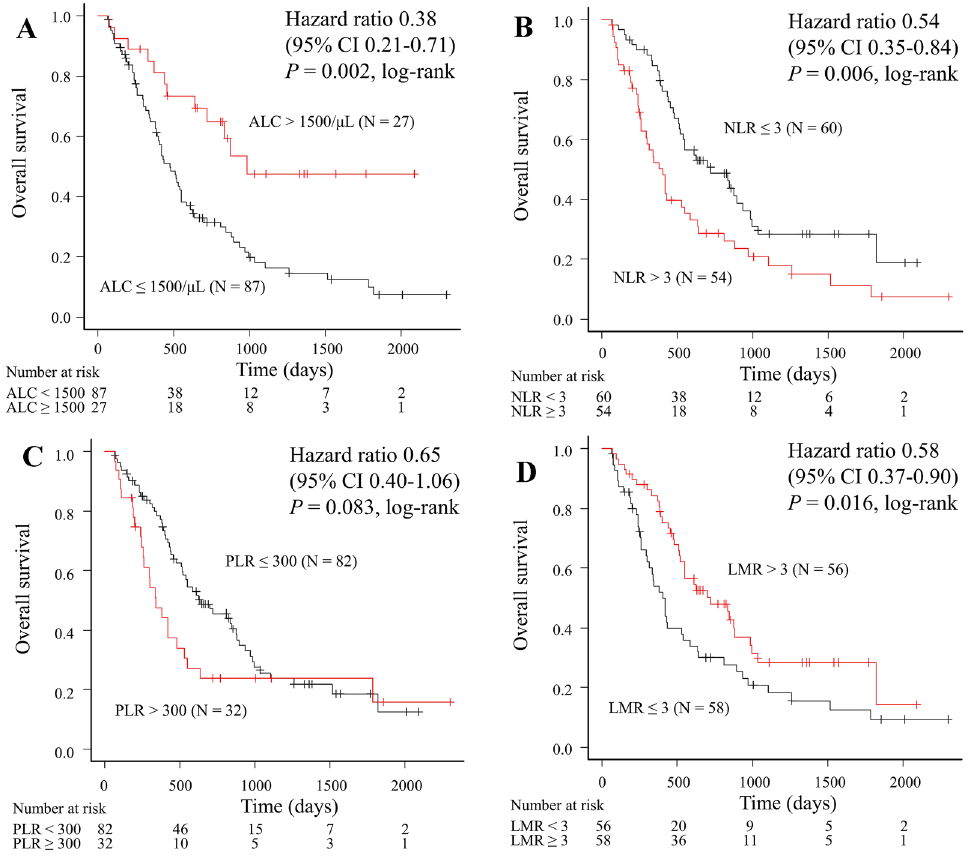
Figure 2. Overall survival according to baseline levels ( A ) ALC, ( B ) NLR, ( C ) PLR, and ( D ) LMR in patients treated with paclitaxel plus bevacizumab. ALC absolute lymphocyte count, CI confidence interval, LMR lymphocyte-to-monocyte ratio, NLR neutrophil-to-lymphocyte ratio, PLR platelet-to-lymphocyte